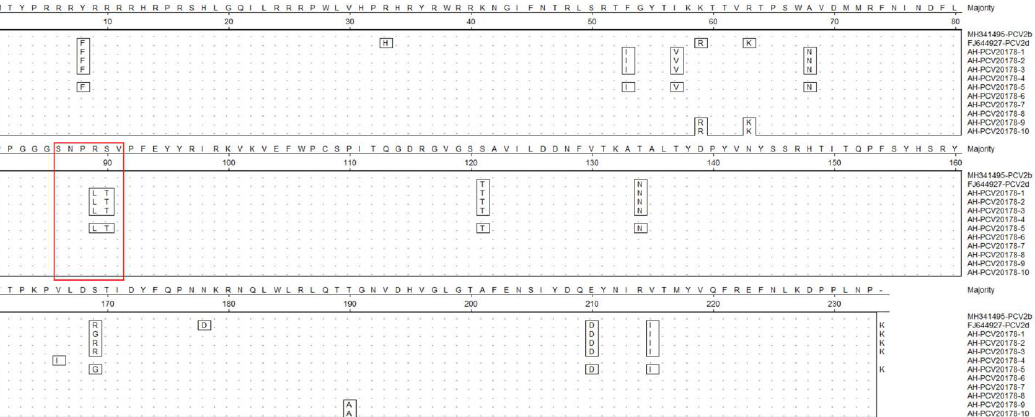
Figure 4. Porcine circovirus type 2 identified in sick pigs: (a), (b) The sequence comparison based on the amino acid sequences of Rep or capsid protein of ten PCV2 isolates identified in this study; (c) phylogenetic analysis based on the nucleotide sequences of the capsid of PCV2 identified in this study and reference strains of other PCV2s. PCV2s identified in this study are marked with a solid red circle.